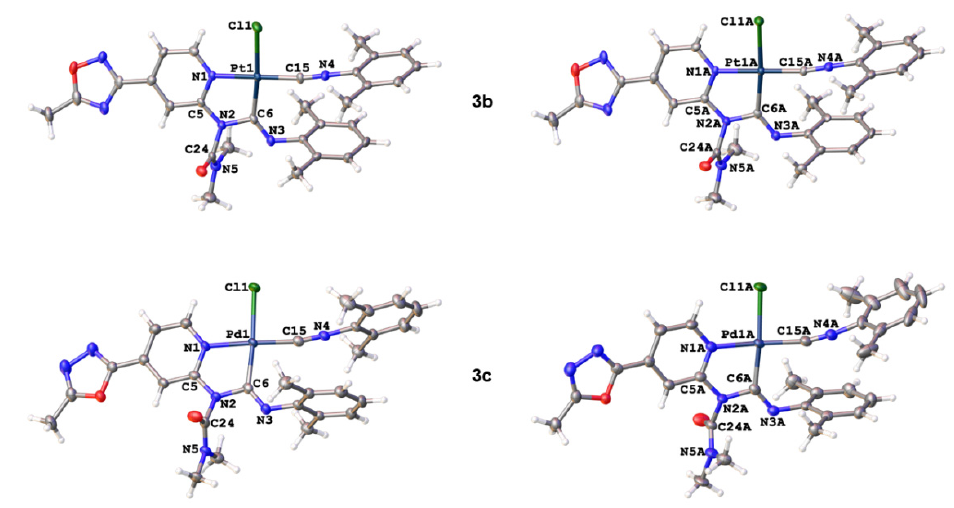
Figure 1. XRD structures of complexes 3b and 3c .